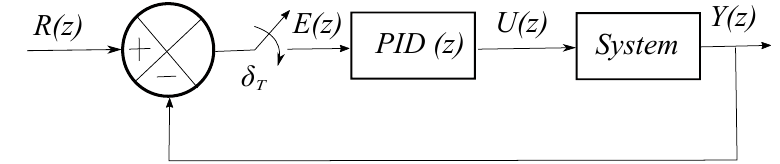
Figure 4. Control loop for conventional PID in discrete